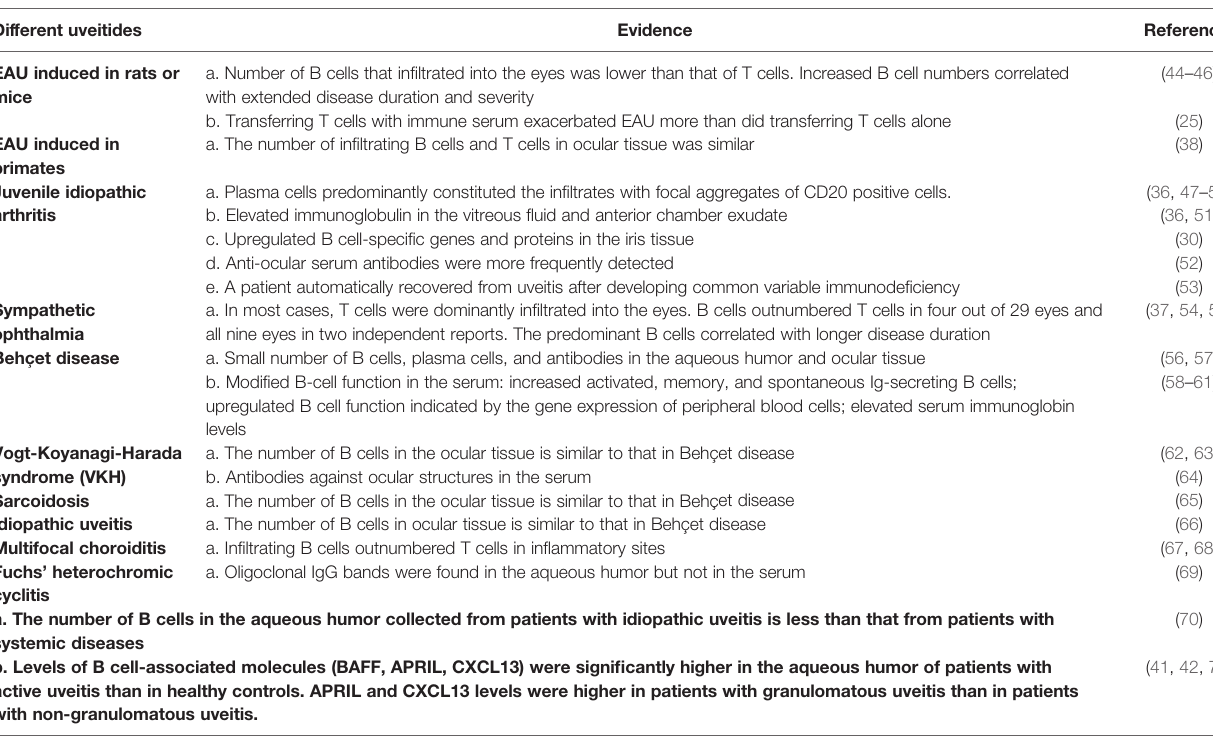
TABLE 1 | Evidence of B-cell participation in different